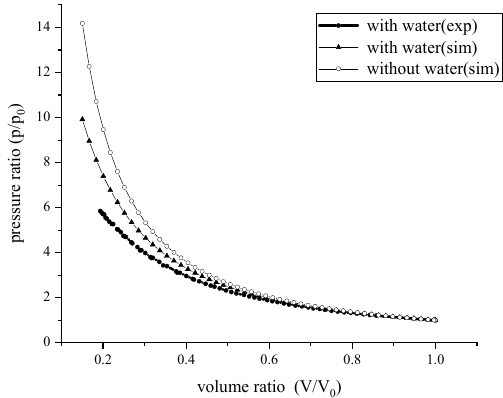
Figure 9. p-V diagram for adiabatic condition.